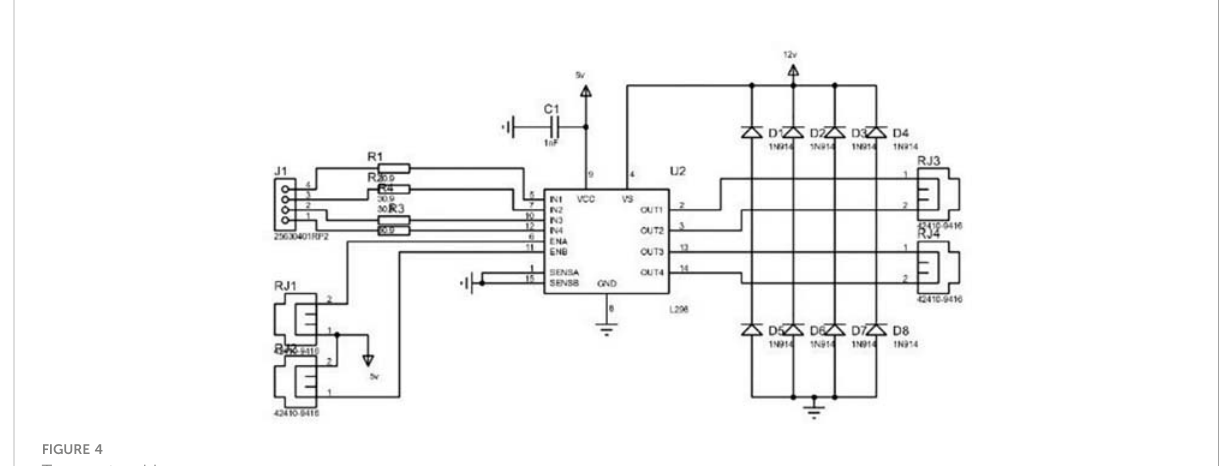
FIGURE 4 Two motor